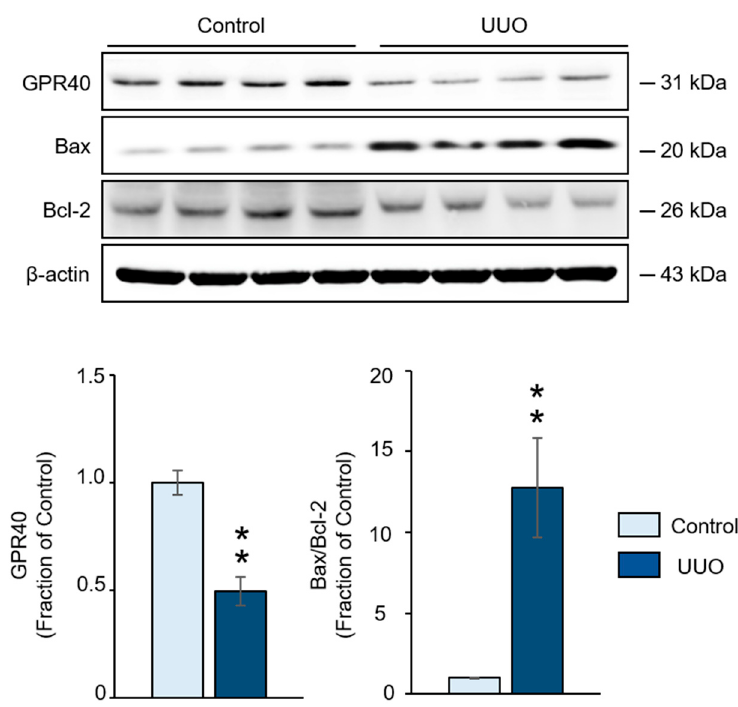
Figure 1. Western blot analyses of G-protein-coupled receptor 40 (GPR40), Bax and Bcl-2 proteins in the ureteral obstructed kidney of mice with unilateral ureteral obstruction (UUO). Representative Western blot and quantitative data are presented. The data are representative of independent experiments. The data are expressed as means ± SEM. n = 4. ** p < 0.01 compared with the control.